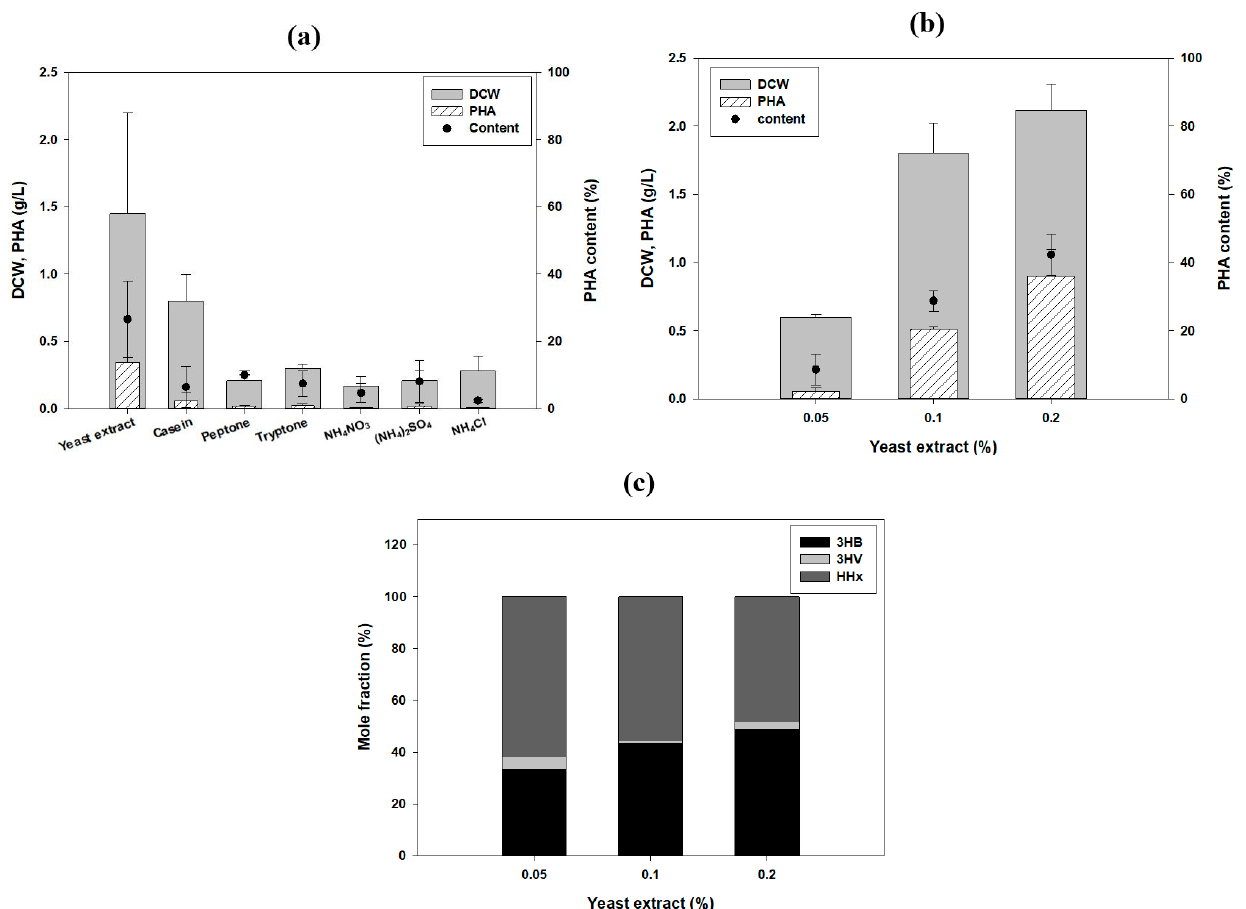
Figure 2. Optimization of the nitrogen source in the polyhydroxyalkanoate (PHA) production medium. ( a ) Cell growth and PHA production were compared in the presence of various nitrogen sources. Effect of the concentration of the yeast extract on ( b ) PHA production and ( c ) PHA mole fraction were obtained. Statistical analysis was carried out by applying ANOVA with the level of significance at 5%. 3HB, 3-hydroxybutyrate; 3HV, 3-hydroxyvalerate; DCW, dry cell weight; HHx, 3-hydroxyhexanoate; OD, optical density.